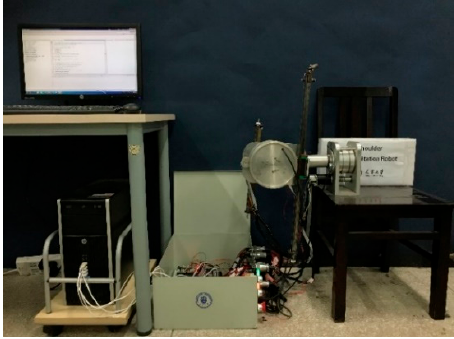
Figure 4. The entire experimental platform.